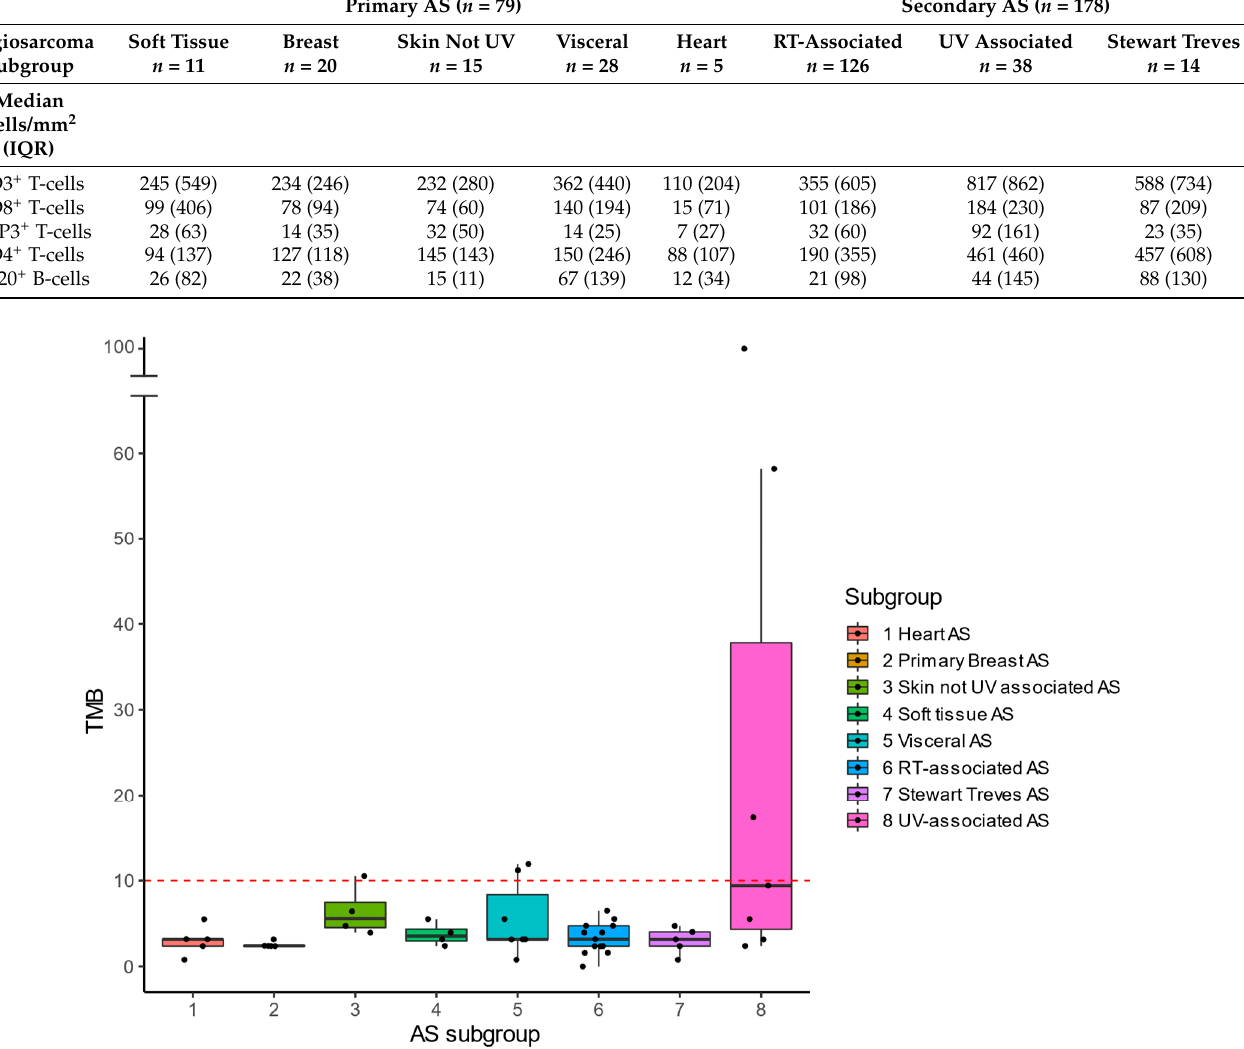
Figure 2. Median TMB per AS subgroup. High TMB ( ≥ 10 mut/Mb) was detected in 6 tumors (12%)